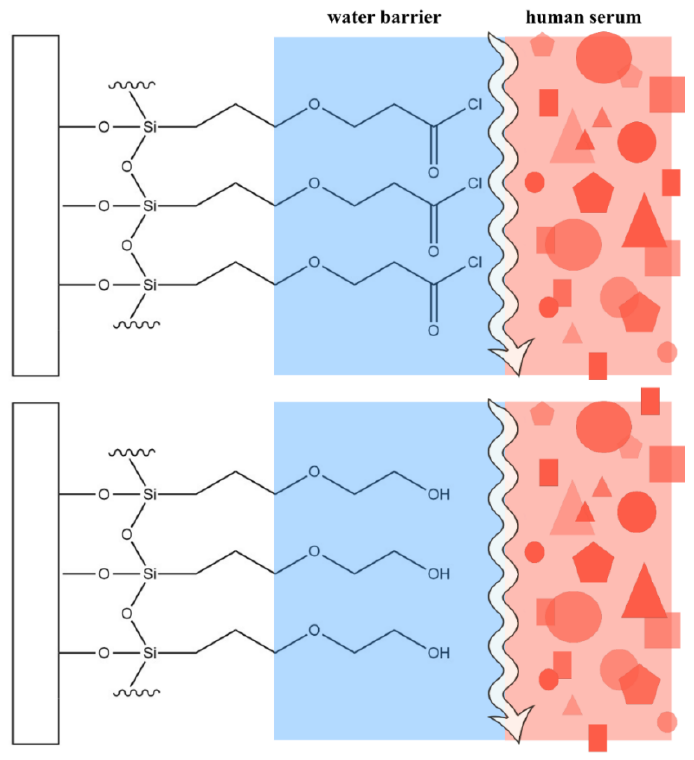
Figure 1. Hydrated MEG-Cl ( above ) and MEG-OH ( below ) adlayers on quartz with antifouling behavior.